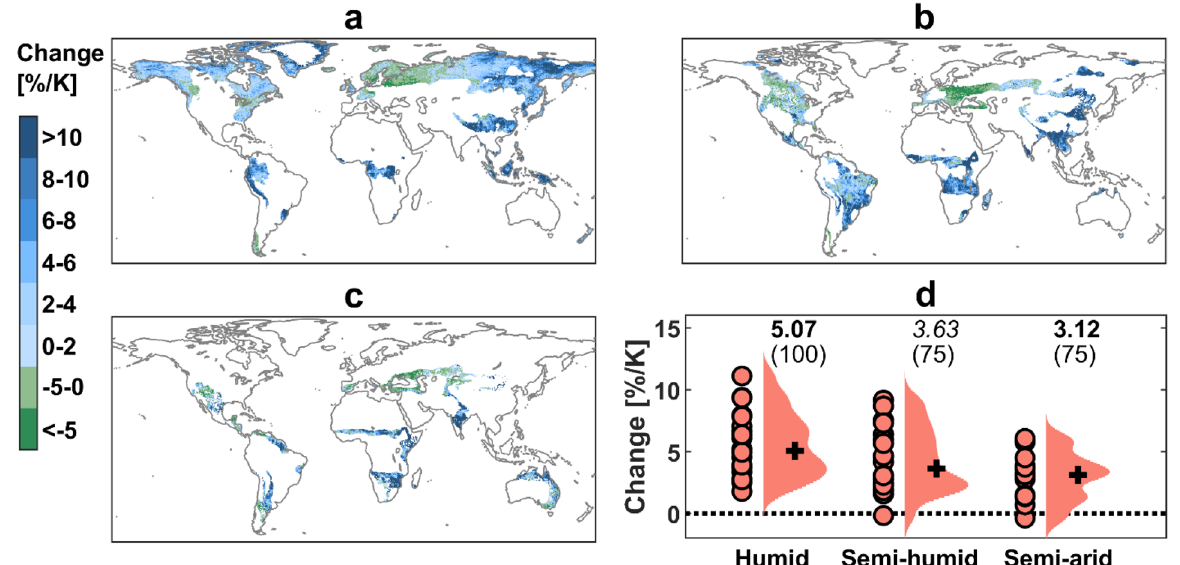
Figure 3. Changes (%) in 1-in-30-year flood intensity per K global warming in 2070–2099 under RCP8.5, compared with 1971–2000. ( a – c ) Spatial distribution of ensemble median changes in ( a ) humid, ( b ) semi-humid and ( c ) semi-arid regions. ( d ) Changes per climate regime based on individual experiments (salmon dots). For each violin, ensemble median is shown by black cross. The numbers on top of the violins (top row) indicate ensemble median and those in bold face and italic denote significant changes at the 95% and 90% confidence levels, respectively. The numbers in brackets indicate the percentage of experiments that agree on the sign of change (robustness). Grid cells with annual maxima close to 0 m 3 s −1 of the historical model period are screened out. The maps were generated using the MATLAB mapping toolbox 65 (URL https ://www.mathw orks.com/produ cts/mappi